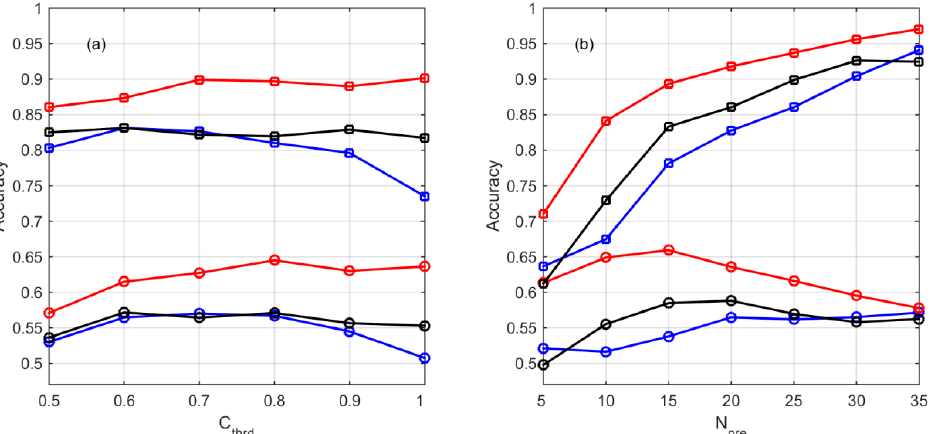
Figure 5. ( a ) The average repeated 10-fold CV scores (circle) and fitting scores (square) of all N pre s dependent on C thrd s, for the schemes single-MLR (blue), F-ratio (black), and L1 (red), respectively. ( b ) The same as ( a ), but for the average scores of C thrd s in the range of 0.5-1 dependent on N pre s.